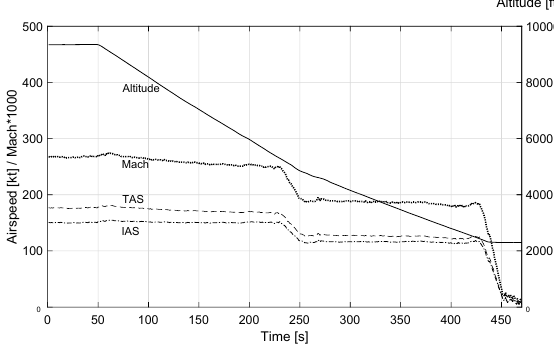
Figure 6. NS872 final landing path for Mission